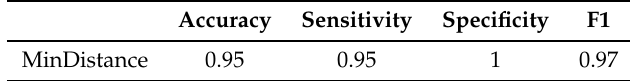
Table 5. Performance obtained in the multi-robot